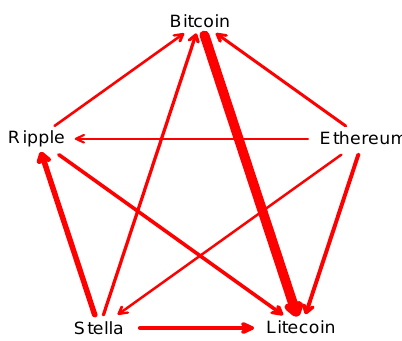
Figure 3. Copula directional dependence among the five cryptocurrencies. The thickness of the arrows reflects the strength of copula directional dependence, with thicker arrows indicating stronger pairwise directional dependence.